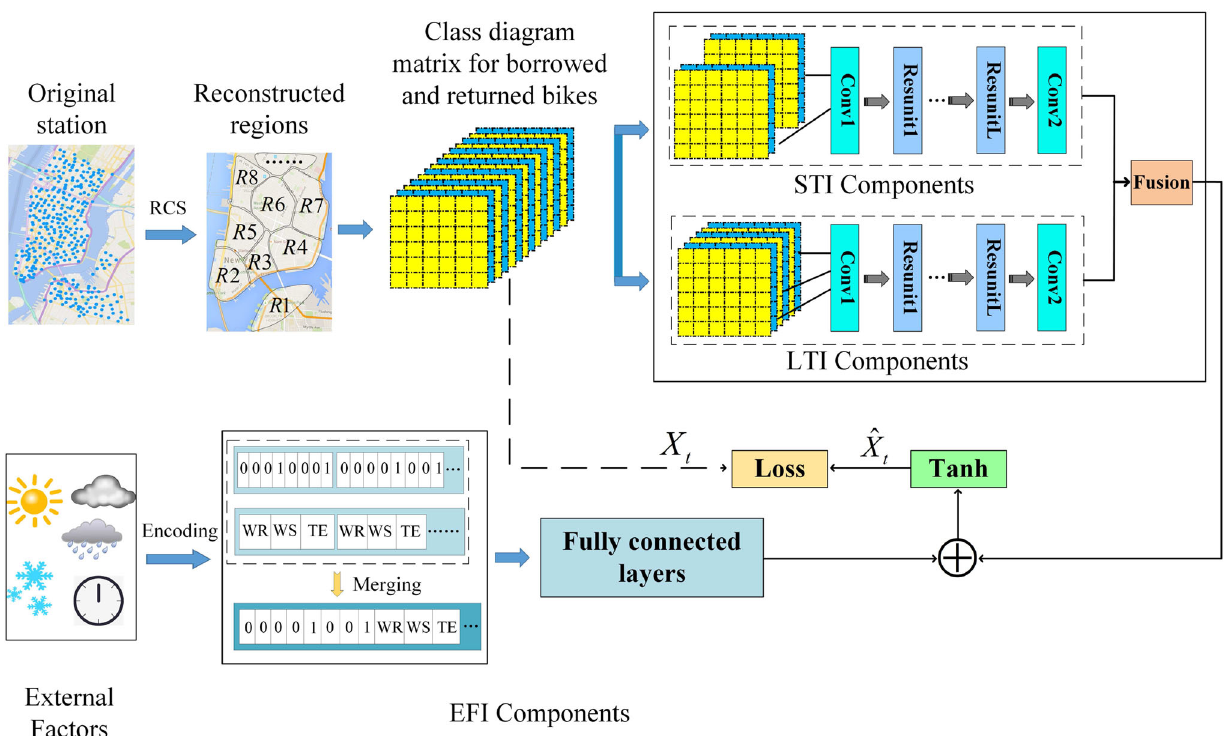
Fig. 3 The framework of RST-Net